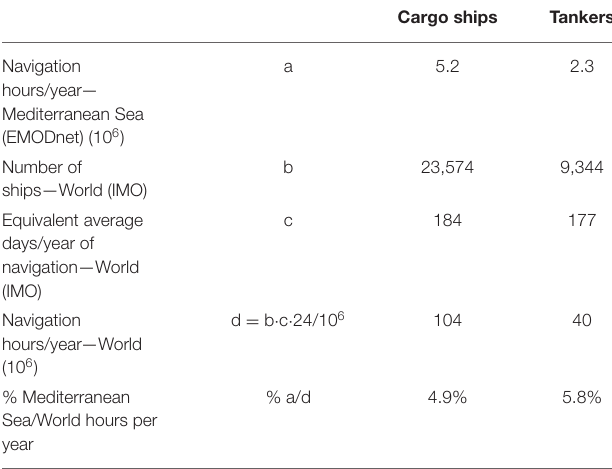
TABLE 2 | Hours of navigation in the Mediterranean Sea and